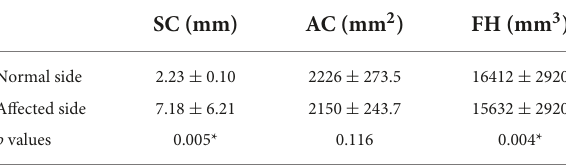
TABLE 3 Preoperative differences of parameters on computer-assisted design (CAD) models of the hip